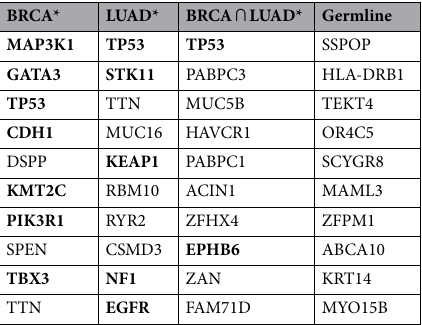
Table 3. Top ten genes with multiple somatic CDS indels in BRCA and LUAD. *The genes are ranked by the number of somatic CDS indels and the genes in bold are the ones in the 125 SMG